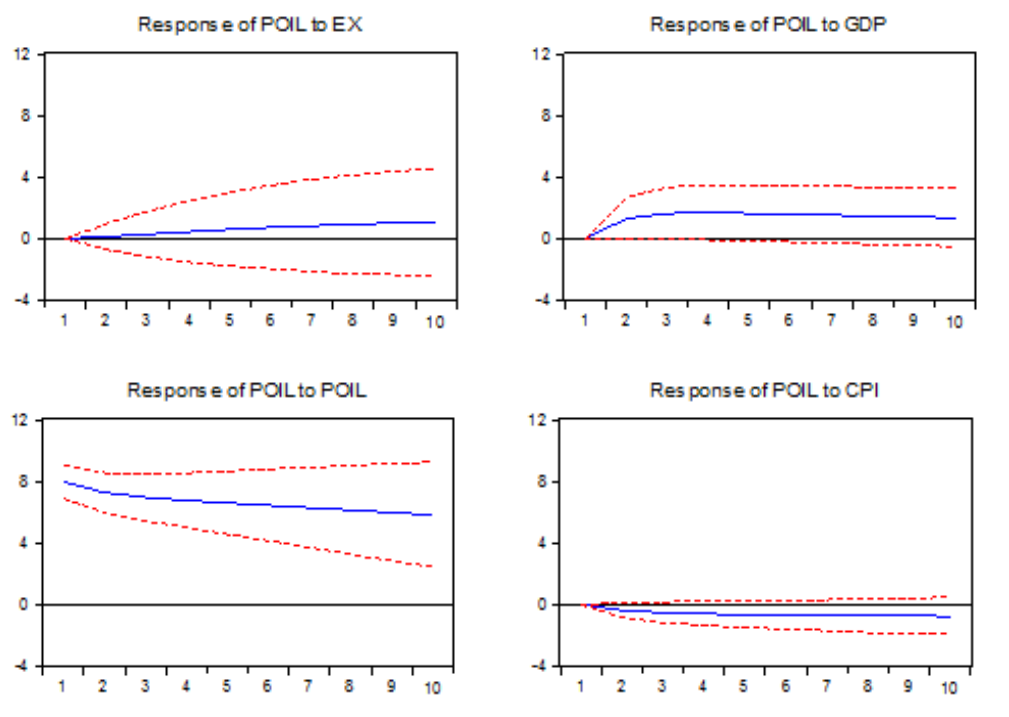
Figure 3. Impulse response functions when shock is applied to oil price Whilst the response functions draw the effect of a shock to an indigenous variable on other variables of the VAR model, analysis of variance (ANOVA) distinguishes the variations in an indigenous variable with the changes in other indigenous variables. Therefore, ANOVA informs on the relative importance of each random shock in influencing the model variables. Table 5. Analysis of variance for price